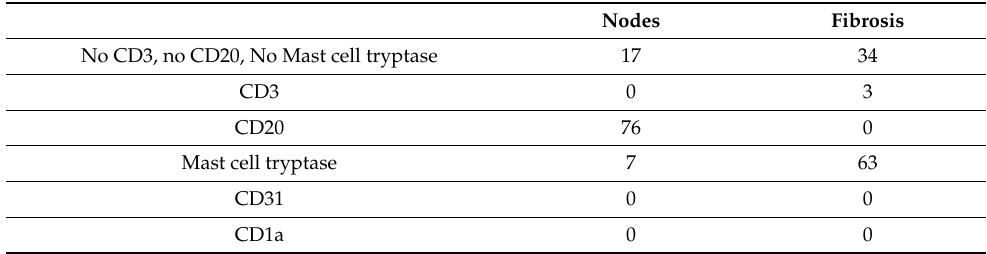
Table 6. Nature of HLA-G cells expressed in percentage according to area of the lung (nodes and fibrosis).